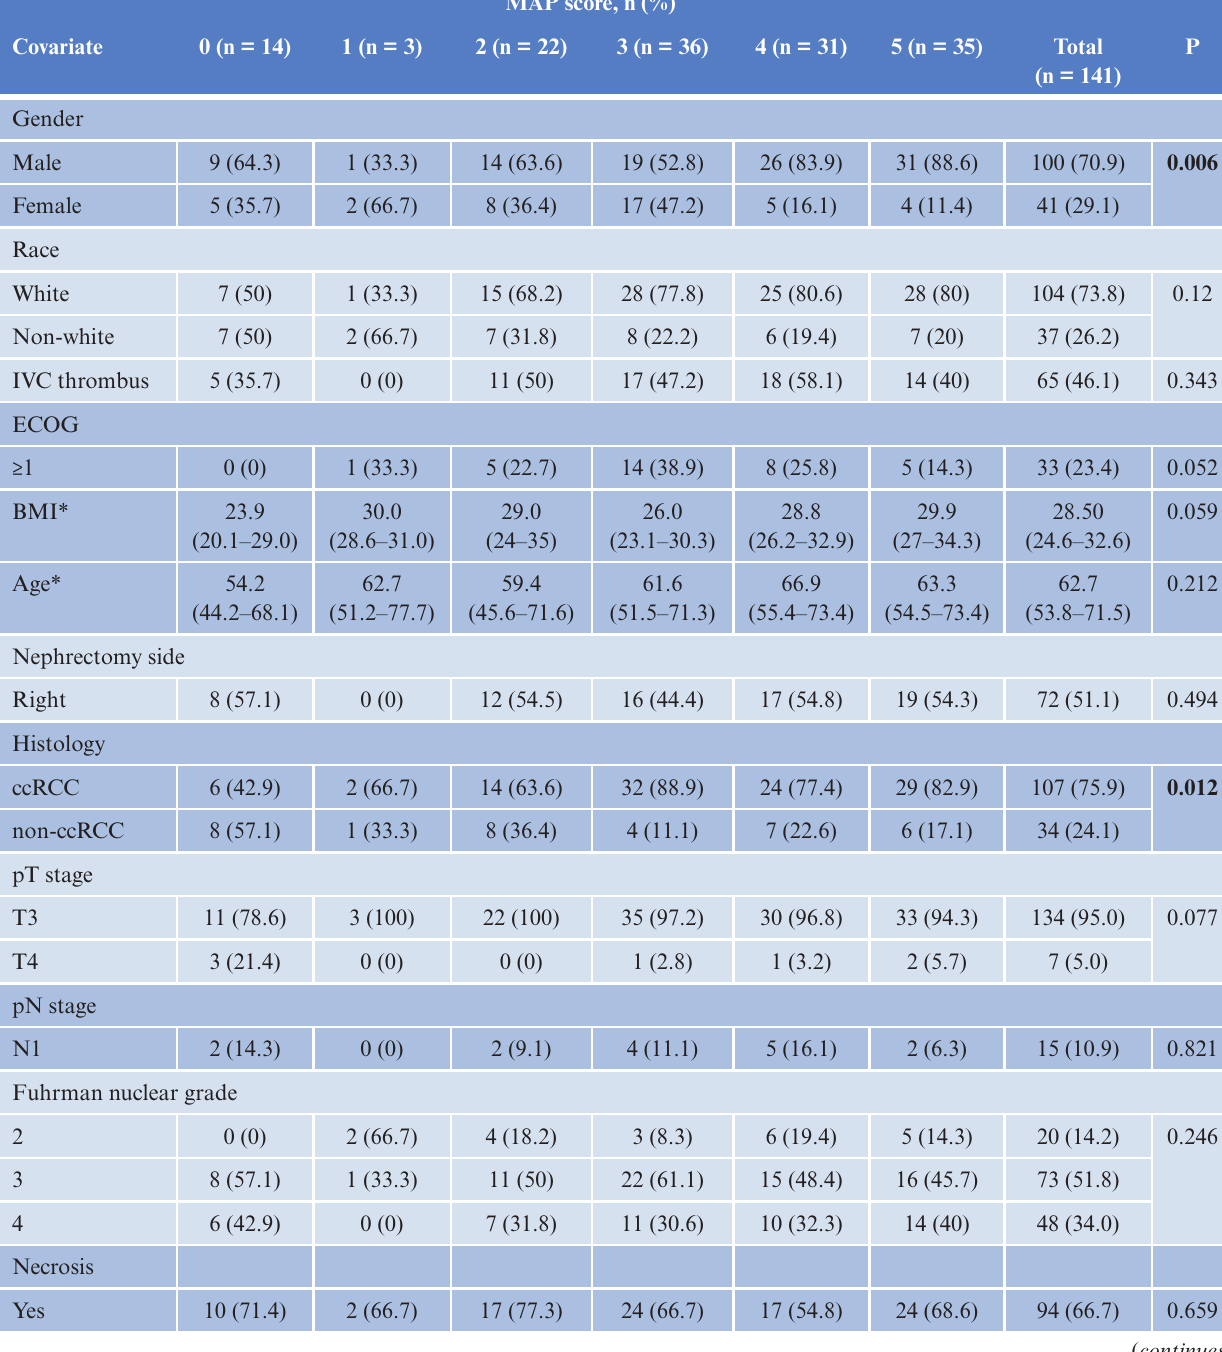
Table 1: Characteristics of study population subdivided by Mayo Adhesive Probability